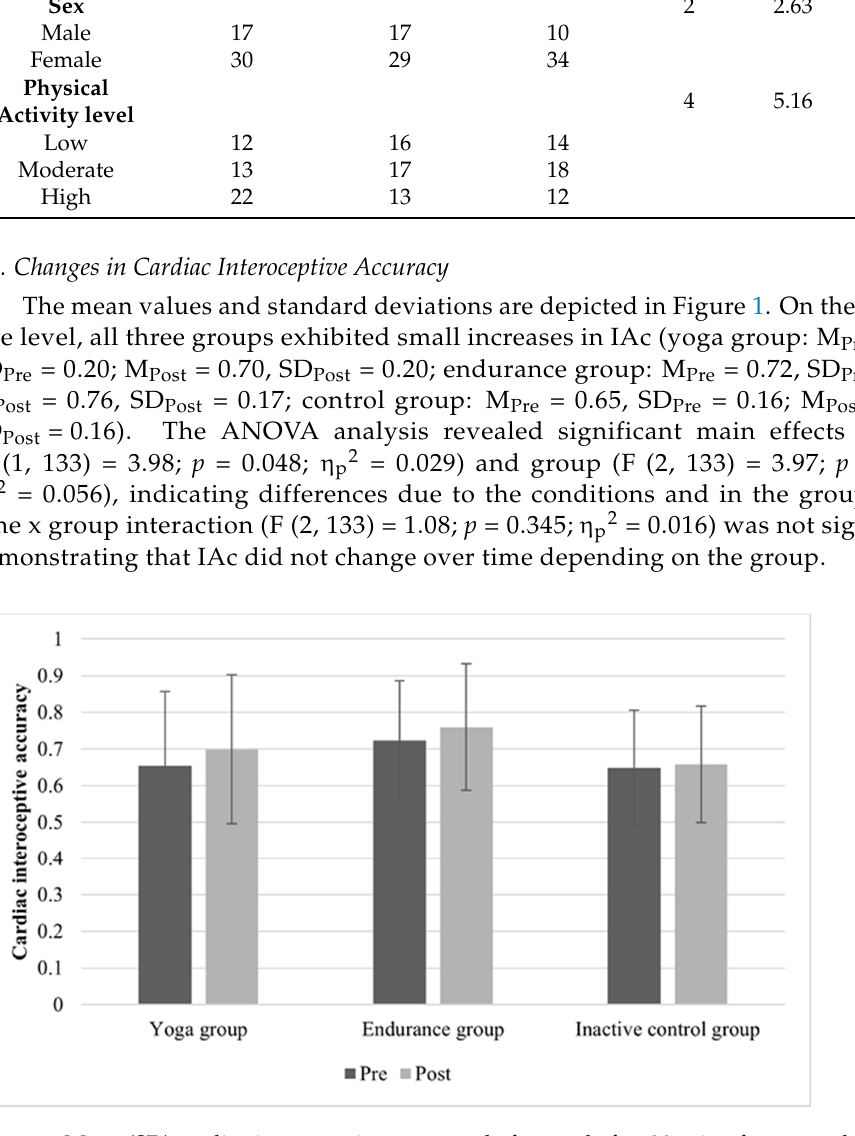
Figure 1. Mean (SD) cardiac interoceptive accuracy before and after 20-min of yoga, endurance, or